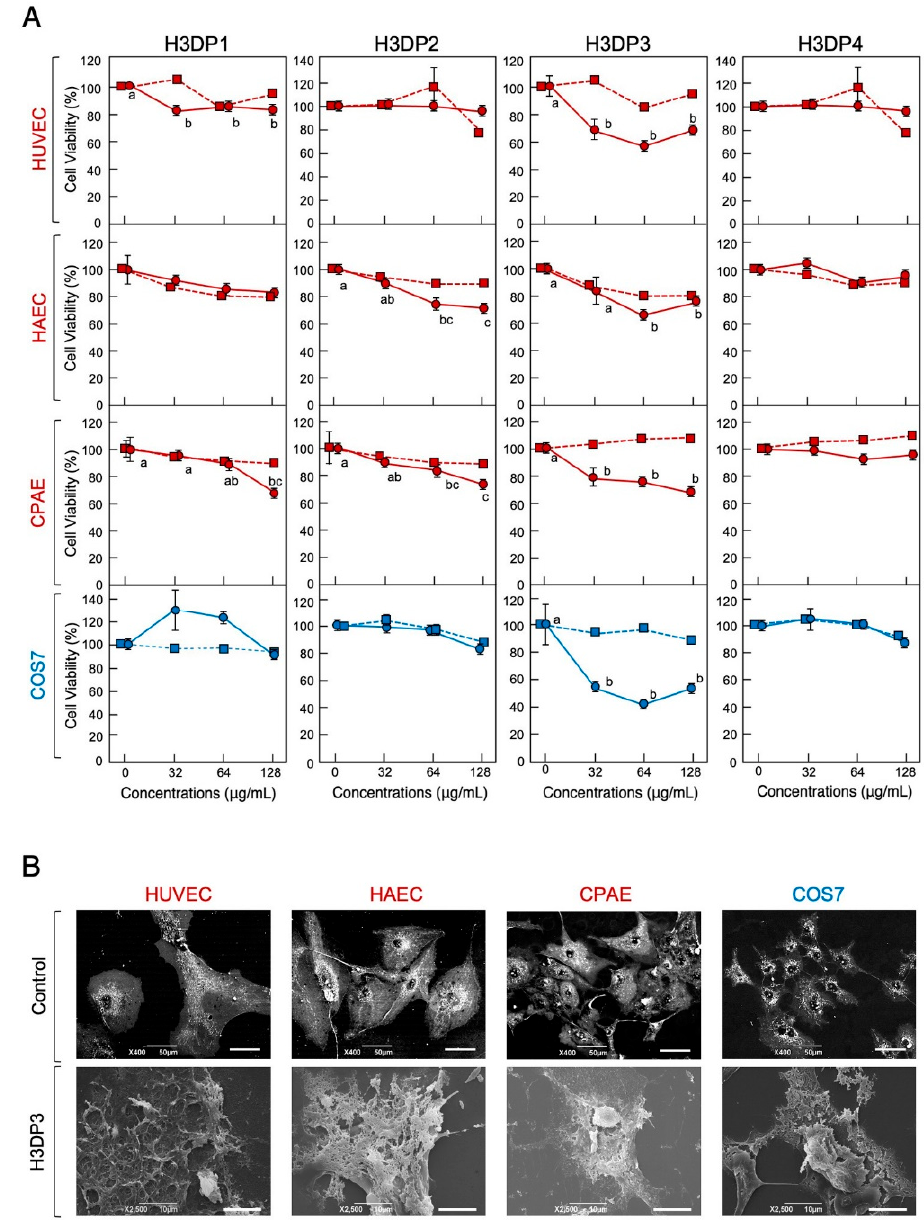
Figure 6. Cytotoxic effects of H3DP1, H3DP2, H3DP3, or H3DP4 on eukaryotic cells ( A ). Medium containing 1 × 10 4 HUVEC, HAEC, or CPAE or 5 × 10 3 COS7 cells in 500 µ L aliquots were incubated with each peptide (circles) or myoglobin (squares) at 0, 32, 64, or 128 µ g/mL for 24 h at 37 ◦ C. Cell proliferation was determined using a standard MTT assay. Cell viability rates were calculated from MTT reduction values and are expressed relative to the control (0 µ g/mL). Each point and vertical bar represent the mean and standard error of the mean, respectively ( n = 4). In each panel, values with the same letters are not significantly different ( p ≥ 0.05). Scanning electron microscopy (SEM) examination of mammalian cells following treatment with H3DP3 ( B ). Aliquots of HUVEC, HAEC, CPAE, or COS7 cells were incubated with H3DP3 or myoglobin (negative control) at 64 µ g/mL for 24 h at 37 ◦ C and were then examined using SEM. Bars, 50 µ m (control) or 10 µ m (H3DP3).